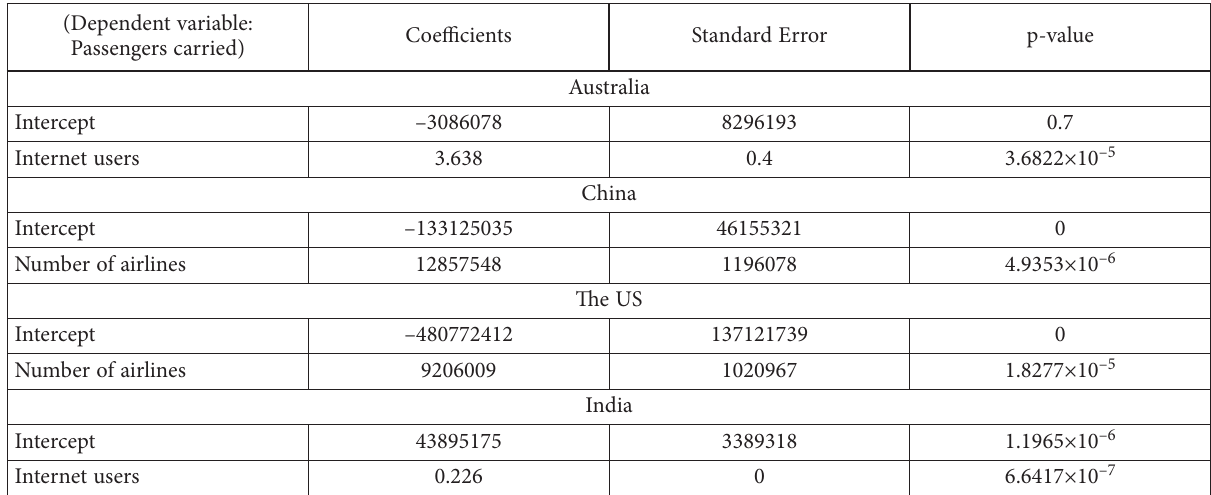
Table 4. Regression analysis of passenger carried in Australia, China, The US, India from 2008 to 2017 (Dependent variable: Passengers carried)